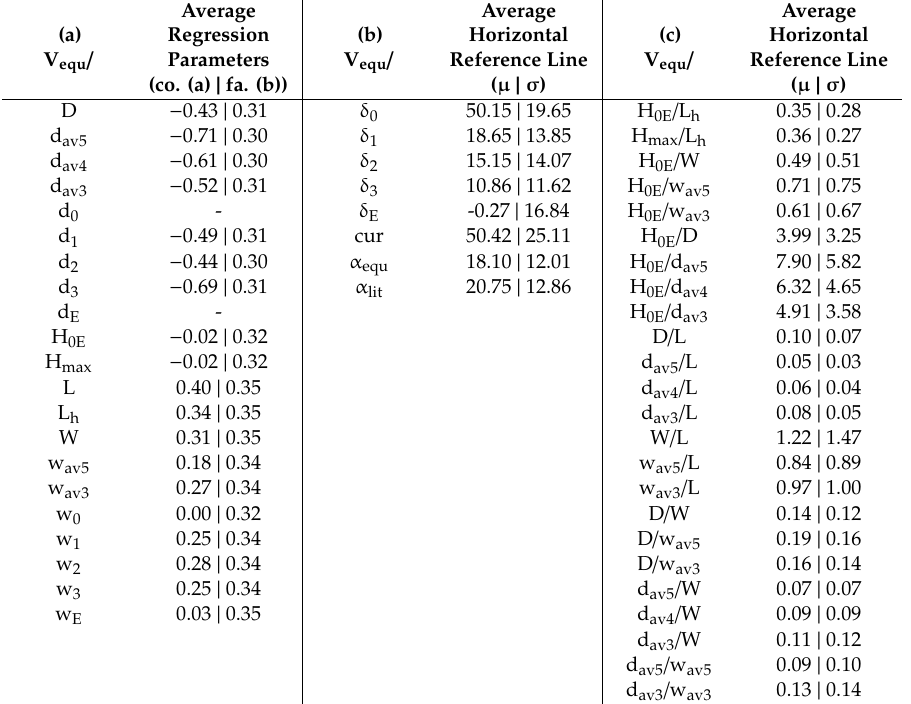
Table 6. Average results for the volume-to-parameter correlations ( a , b ) and for the volume-to-ratio correlations ( c ). For all dimension-related parameters ( a ), the average regression parameters (constant (a) and factor (b); Equation (2)) are given; for all shape-related parameters ( b , c ), the table shows the average mean values ( µ ) with the respective average standard deviations ( σ ). As d 0 contains 0 and d E is always 0, they are not fitted in a double-logarithmic